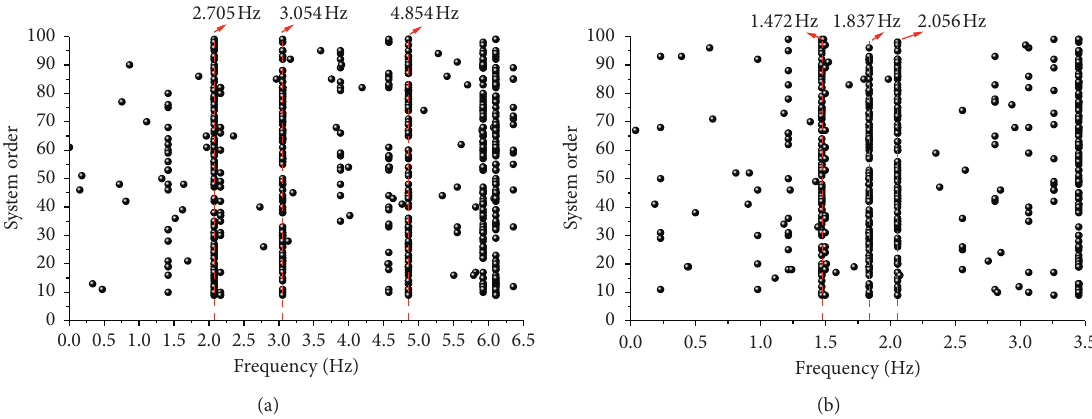
Figure 6: Vibration stability map of stochastic subspace identification. (a) SSI vibration stability diagram of climbing formwork under construction condition. (b) SSI vibration stability diagram of climbing formwork under climbing condition.